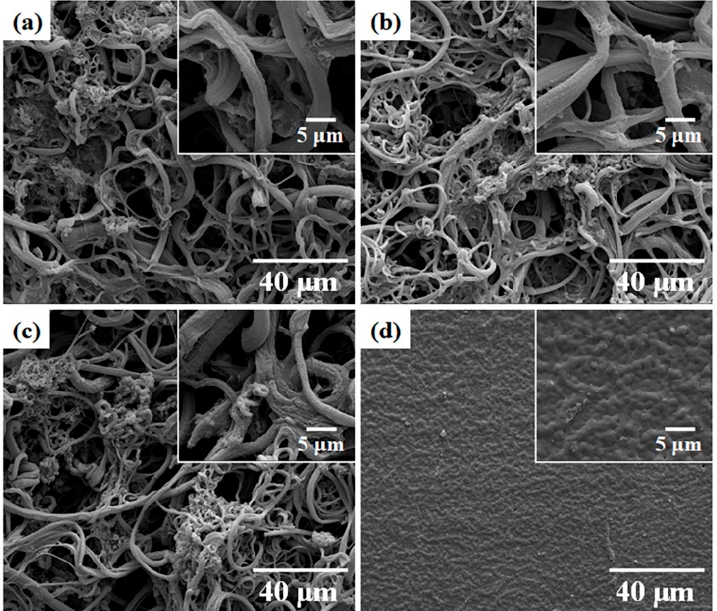
Figure 4. Surface topography of the coatings with same CNTs of 30 wt. % and different SiO 2 nanoparticles contents: ( a ) 0 wt. %, ( b ) 15 wt. %, ( c ) 45 wt. %; ( d ) surface topography of the coatings with SiO 2 nanoparticles of 75 wt. %.